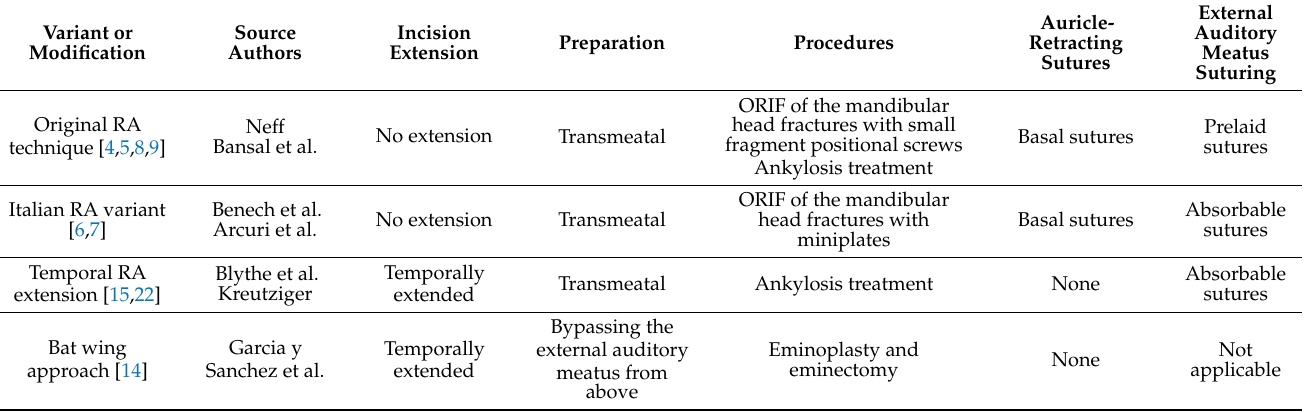
Table 6. Synthesized data on RA variants and modifications. ORIF-open reposition and internal fixation. Variant or